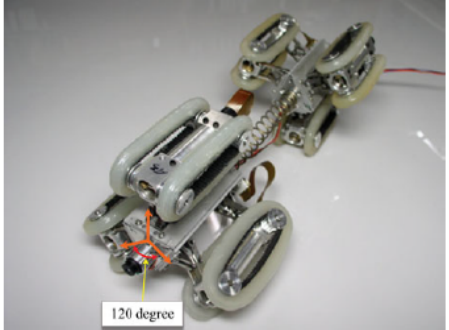
Figure 38. A two-segment in-pipe robot with caterpillar wheels. Reprinted under Creative Commons CC BY license [119].